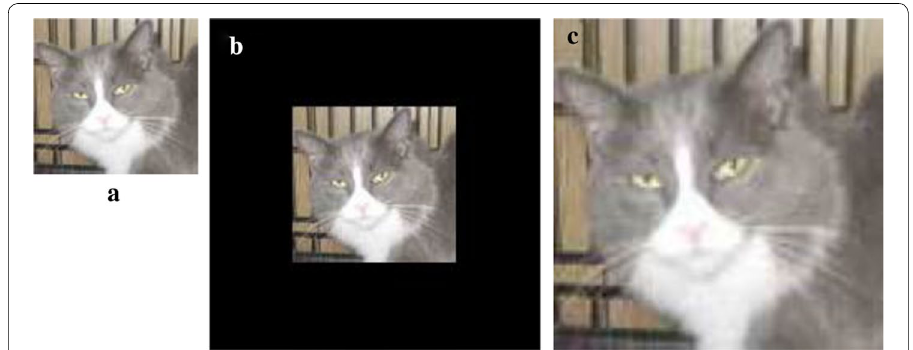
200 pixels using zero-padding ( b ) and interpolation ( c ×